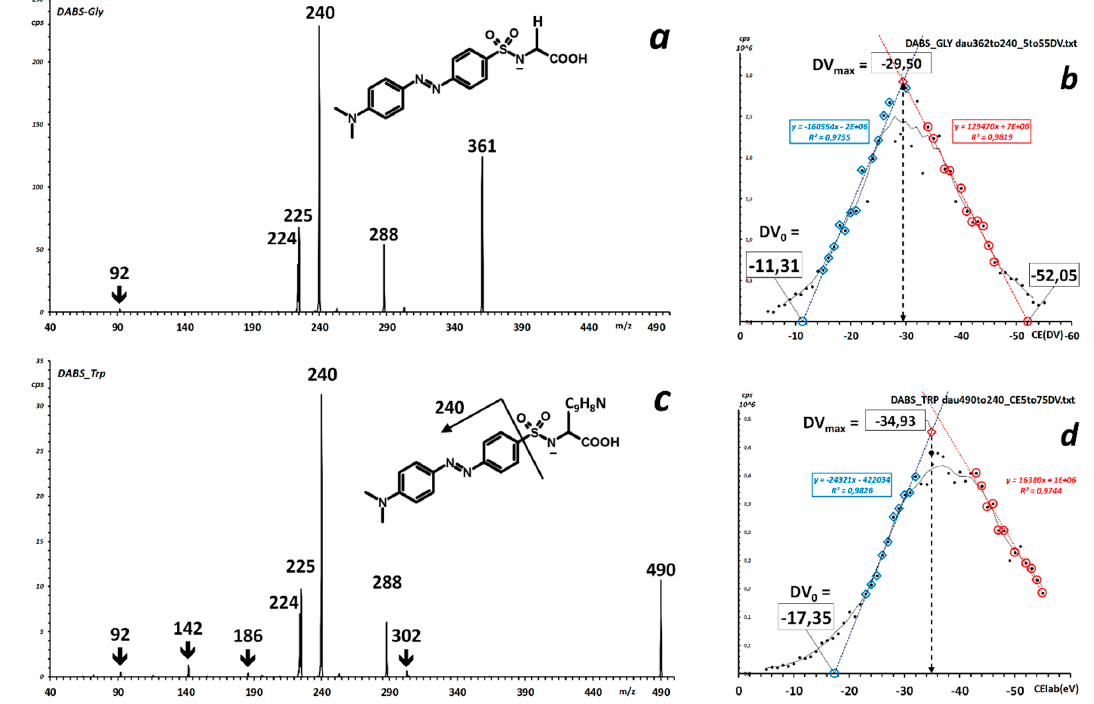
Figure 3. Integrated fragment spectra of dabsylated Glycine ( a ) and Tryptophan ( c ). The insert to each spectrum shows the relationship of the most intense fragment to molecular connectivity. The fragment generation efficiency curve of m / z − 240 (laboratory frame collision potential) is reported, for each DABS-AA, in the right panels ( b ) and ( d ).